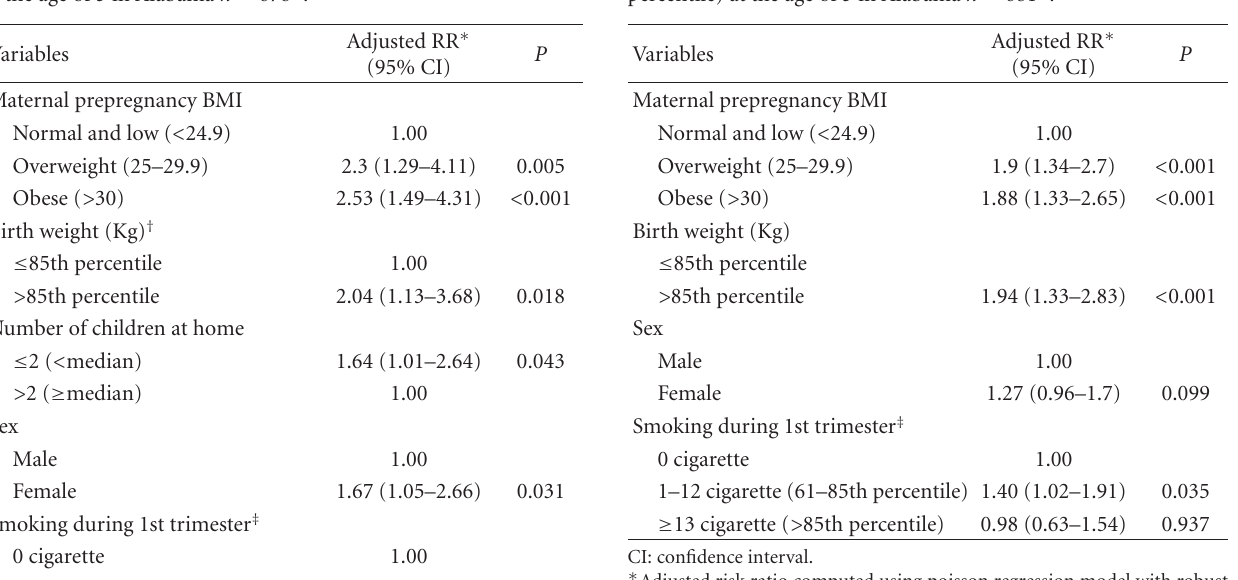
Table 3: Multivariable model showing adjusted risk ratio for mater- nal and early childhood determinants of obesity ( ≥ 95th percentile) at the age of 5 in Alabama n = 678 ∗ .